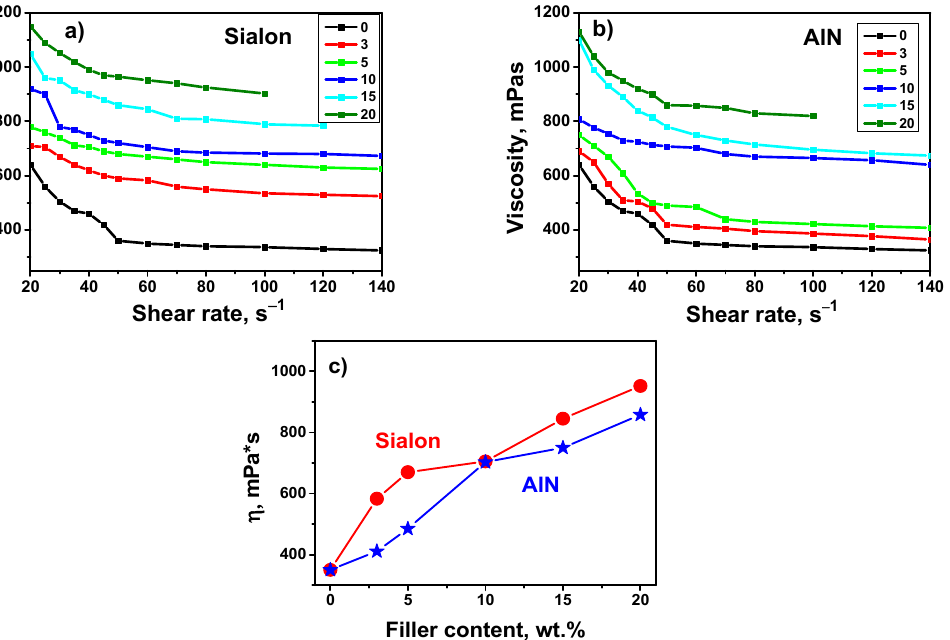
Figure 2. The viscosity of a composition as the function of the shear rate and the filler content at 25 °C; ( a ) Sialon, ( b ) AlN and the dependency of the viscosity of the formulation as the fillers content function at a shear rate ~60 rpm, ( c ) The numbers indicate the filler content as a weight percent. The lines are guides for the eye.